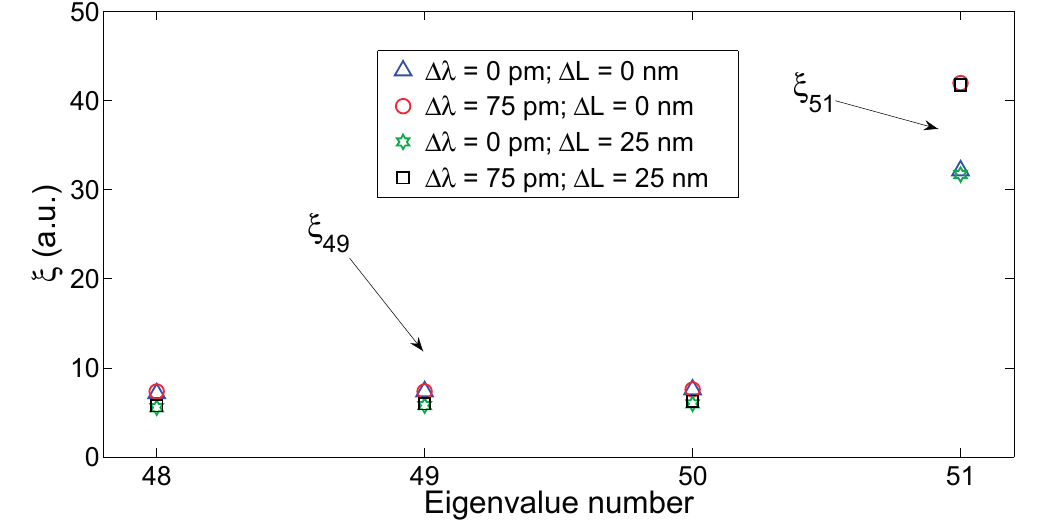
Figure 11. KLT-SVD applied to the dual FBG/FPI sensor. The chart reports the eigenvalues ξ , when either the FBG is shifted by 75 pm, or the FPI cavity length is expanded by 25 nm, or both events occur. The chart reports the highest rank eigenvalues (48–51), significant for demodulation.